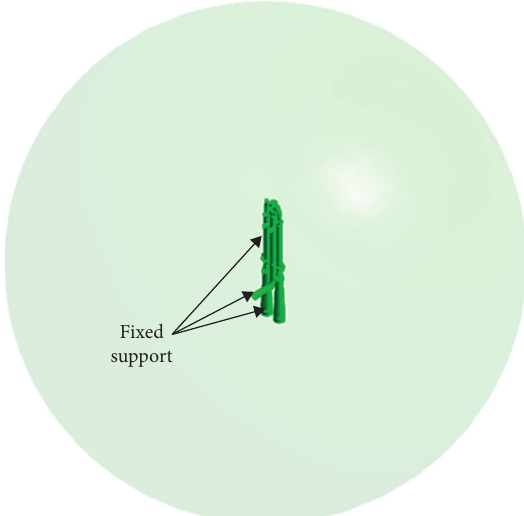
Figure 4: Volume control used in the evaluation of the natural frequencies of a jet pump assembly.